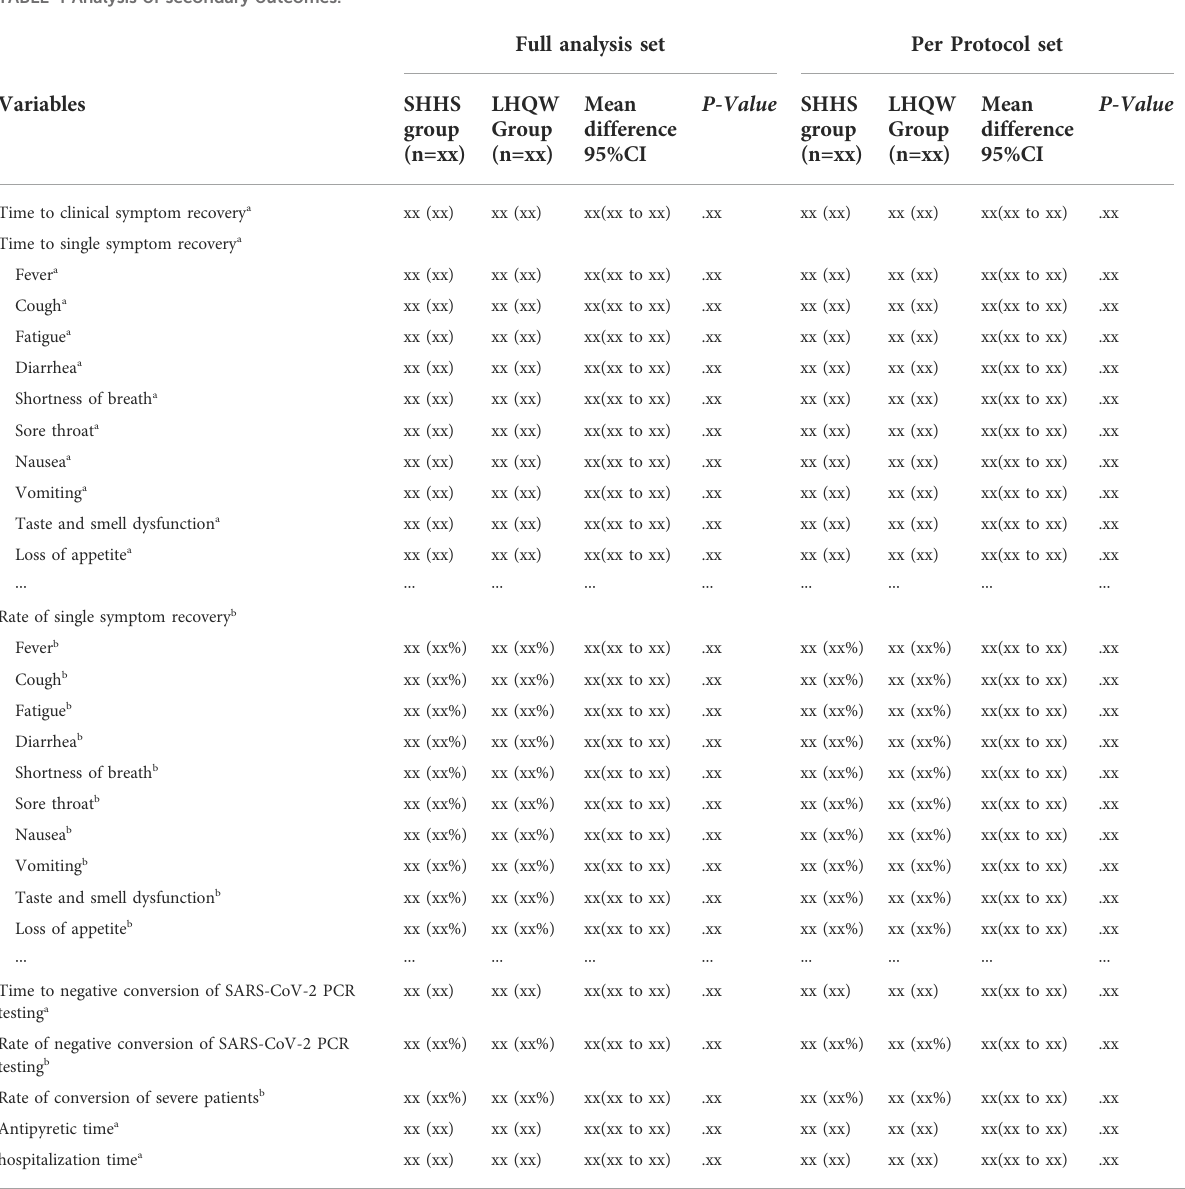
TABLE 4 Analysis of secondary